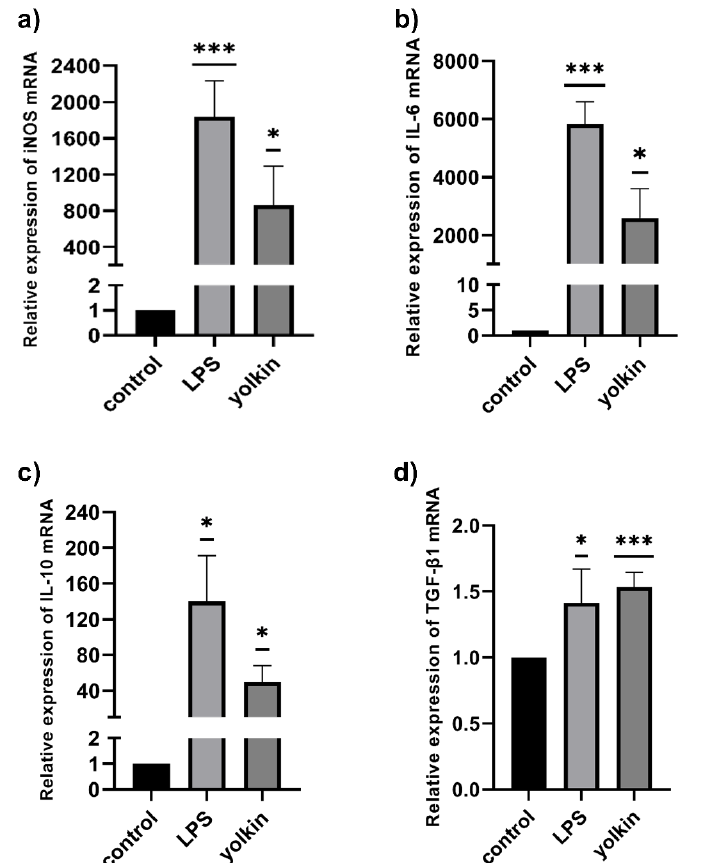
Figure 5. The impact of yolkin on the regulation of iNOS ( a ), IL-6 ( b ), IL-10 ( c ) and TGF β ( d ) mRNA expression. BMDM cells (1 × 10 6 /mL) were stimulated with yolkin (100 µ g/mL) or LPS (1 µ g/mL). After 4 h of stimulation, total RNA was isolated from the cells and the expression of iNOS ( a ), IL-6 ( b ), IL-10 ( c ) and TGF β ( d ) mRNA was determined using real-time PCR tests. Experiments were repeated at least three times and data are presented in relative expression units, where Actb was used to normalize all samples. Control cells were assigned an arbitrary value of 1. A one-sample t-test was used to examine the mean differences between samples and control; * p ≤ 0 .05; *** p ≤ 0 .001 vs. control.